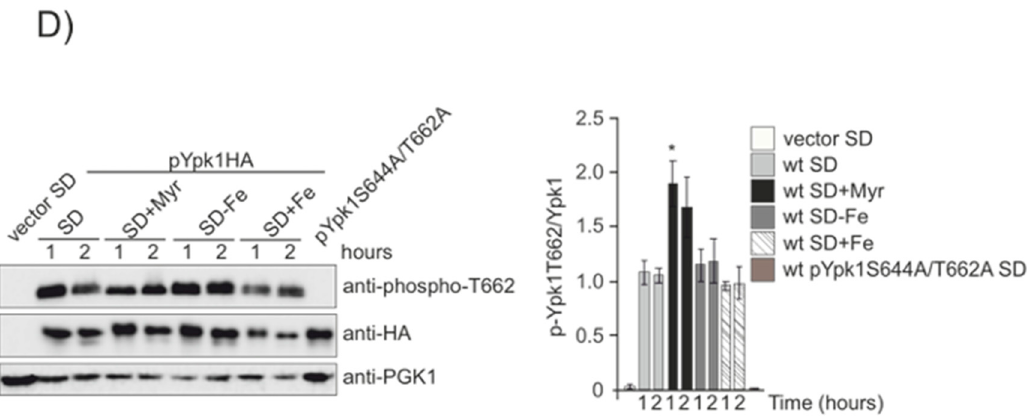
Figure 4. TORC2 phosphorylation to Ypk1 regulates iron starvation signal. ( A ) wt, ypk1, ypk1 +pYpk1HA and ypk1 +pYpk1 S644A/T662A transformed with the plasmid pAft1GFP, were logarithmically grown in SD medium plus amino acids or in iron-free SD (SD-Fe) to be observed in fluorescence microscopy. The histogram represents percentages of in vivo nuclear, cytoplasmic, vacuolar or mitochondrial localization out of 1000 cells. ( B ) Strains wt, ypk1, ypk1 +pYpk1HA and ypk1 +pYpk1 S644A/T662A were each transformed with plasmid p FET3 -LacZ. Cells were grown at 30 °C in SD media overnight to OD 600 :0.6. ( C ) Intracellular iron content was determined in wt, ypk1, ypk1 +pYpk1HA and ypk1 +pYpk1 S644A/T662A exponential cultures grown in SD or SD-Fe media as described under Material and Methods. ( D ) wt strain was transformed with pC-terminal3-HA, pYpk1HA or pYpk1 S644A/T662A . Cells were grown in SD to the exponential phase, the cultures were washed and transferred to SD, SD+Myr, SD-Fe or SD+Fe samples were collected at indicated times for Western blot analysis, probing with anti-phospho-T662, anti-HA and anti-PGK1 antibodies. The histogram represents the ratio between Ypk1 phospho-T662 and total Ypk1. * 0.05 > p > 0.01; ** 0.01 > p > 0.001.